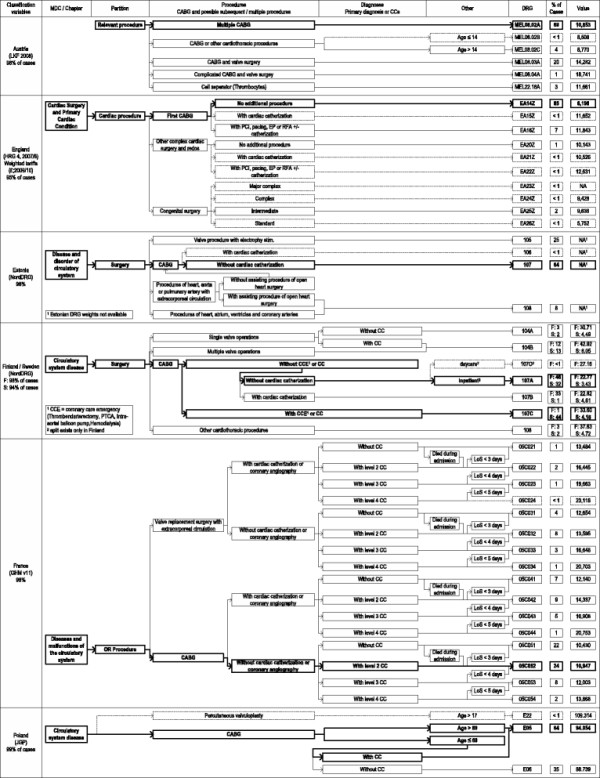
Grouping structure.